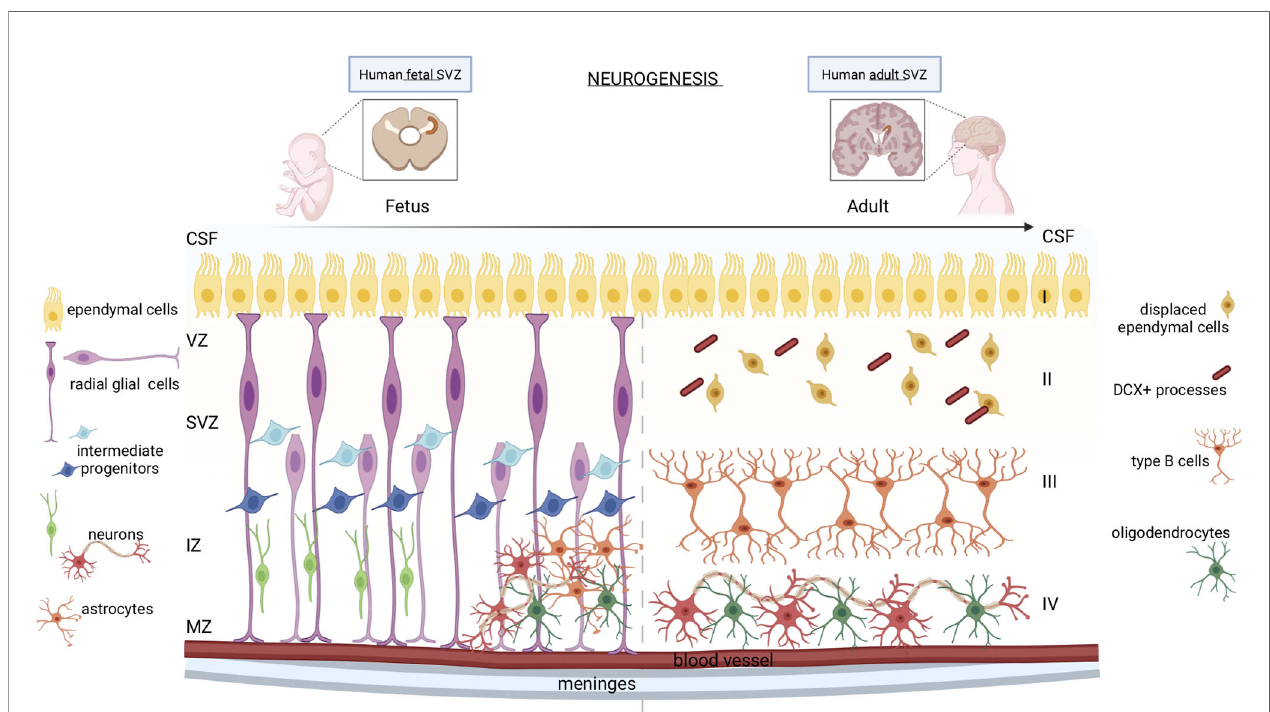
FIGURE 1 | Neurogenesis in human fetal and adult SVZ. In the fetal brain, the neurogenic niche is organized into different strata: the ventricular zone (VZ), the subventricular zone (SVZ), the intermediate zone (IZ), and the marginal zone (MZ). Apical radial glial cells of the SVZ remain in contact with the ependymal cells and with the meninges and blood vessels, while the basal radial glial cells, which constitute the region of the SVZ called outer SVZ (oSVZ), lose contact with ventricles leading to a discontinuous scaffold of radial glial cells (RGCs). Apical and basal RGCs generate neurons through two mechanisms: either directly or indirectly through intermediate progenitor cells, which also originate astrocytes and oligodendrocytes. In the adult brain, the SVZ consists of four distinct strati fi ed areas: layer I formed by ependymal cells in contact with the lumen of ventricles; the hypocellular gap (layer II), mainly formed by displaced ependymal cells and DCX+ astrocyte processes; layer III constituted by type B astrocytic cells; a transitional region to the brain parenchyma (layer IV) formed by mature neurons and